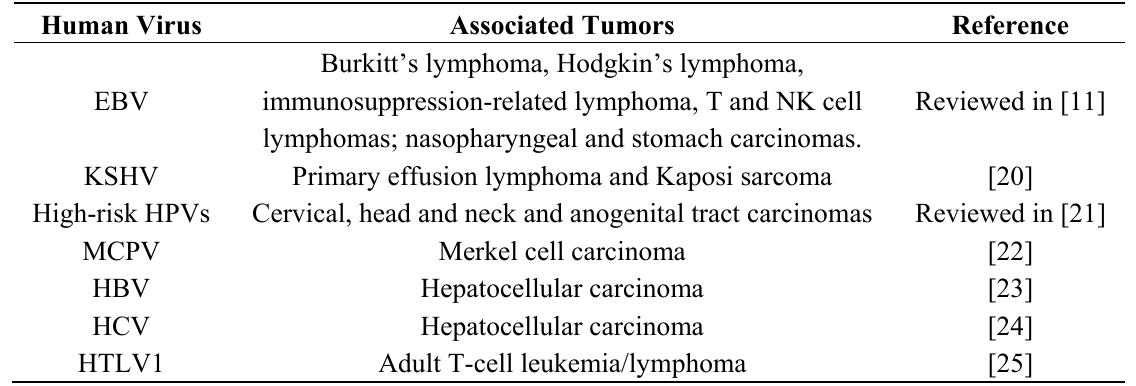
Table 2. Human oncogenic viruses and their associated